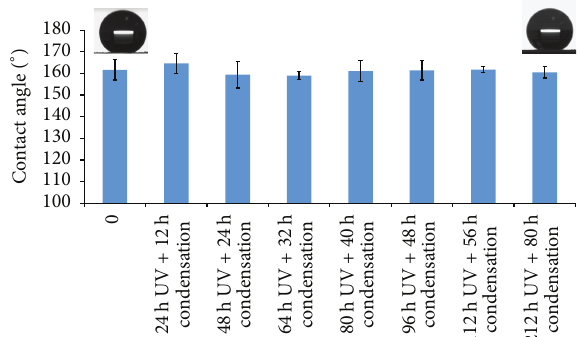
Figure 5: UV stability test results for the superhydrophobic coating.